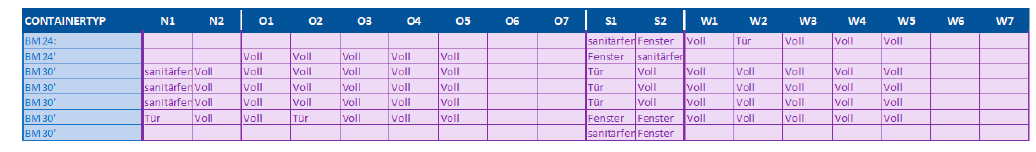
Figure 10. Screenshot of Container Manager : Export panel configuration from BIM model.